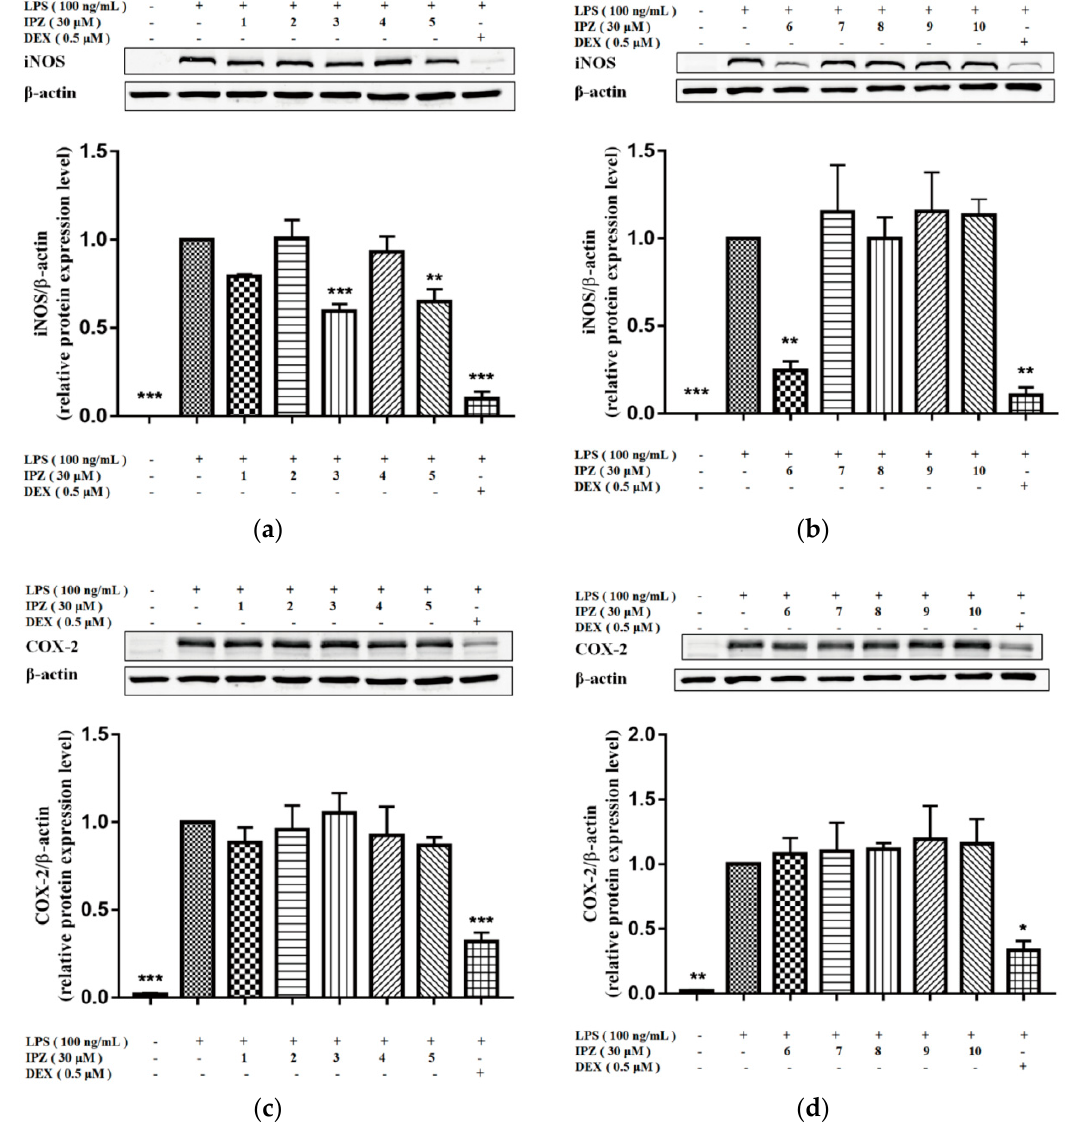
Figure 4. Effect of compounds 1 – 10 (IPZ 1-10) on inducible nitric oxide synthase (iNOS) and cyclooxygenase-2 (COX-2) protein expression in lipopolysaccharide (LPS)-stimulated RAW264.7 cells. RAW264.7 cells were seeded in 24-well plate and cultured overnight. Subsequently, compounds 1 – 10 and the positive control dexamethasone (DEX) were administered to RAW264.7 cells for 1 h, and LPS (100 ng/mL) was used to stimulate the cells for the final 18 h. Western blotting was performed to analyze protein expression of iNOS, COX-2, and the corresponding values were quantitated by Odyssey v3.0 software. The results are expressed as the mean ± SEM, n = 3. * p < 0.05, ** p < 0.01, *** p < 0.001, vs. LPS group.